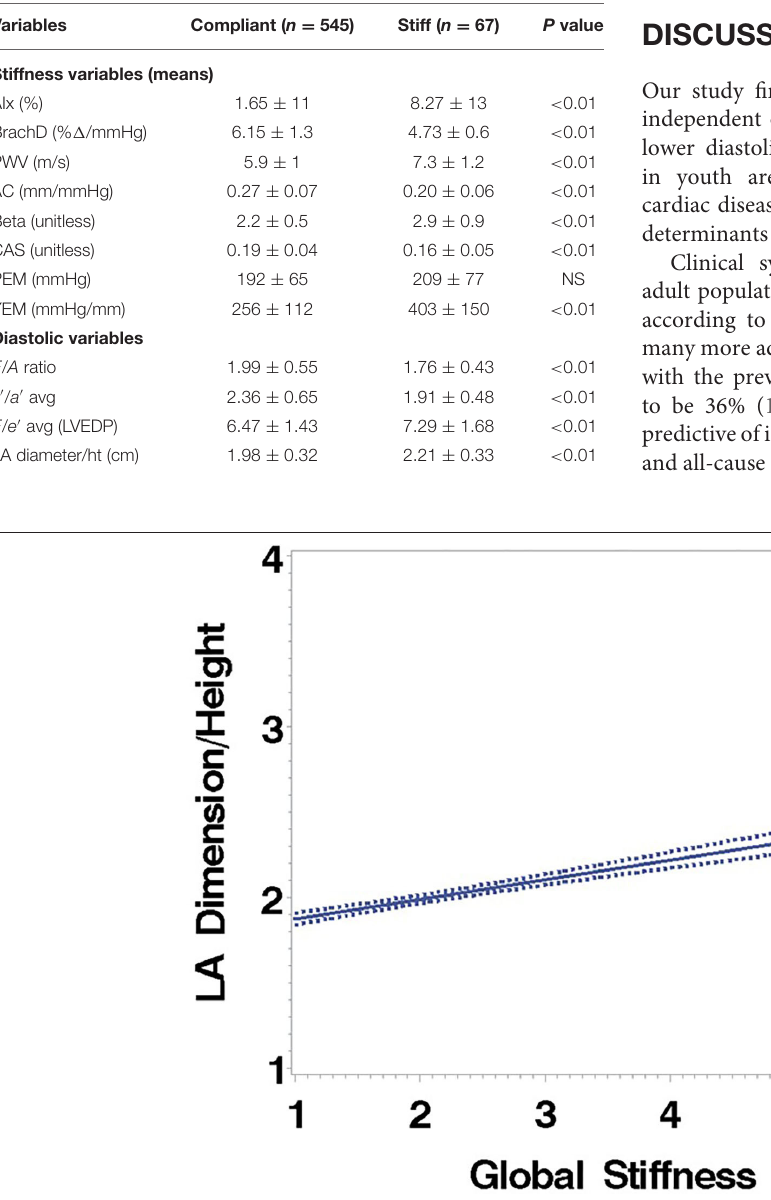
Frontiers in Pediatrics |